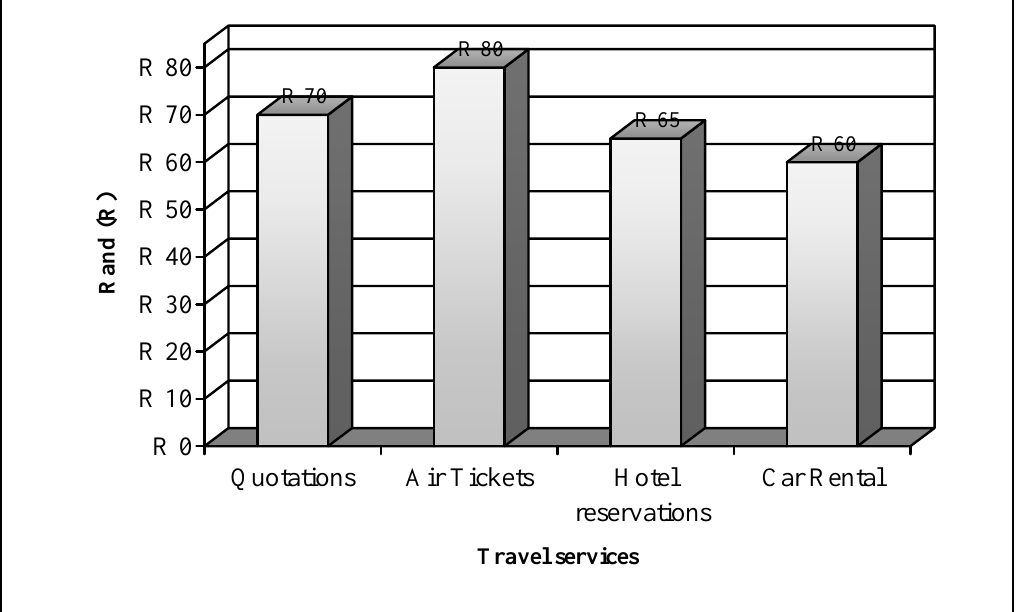
Service fees for national travel arrangements